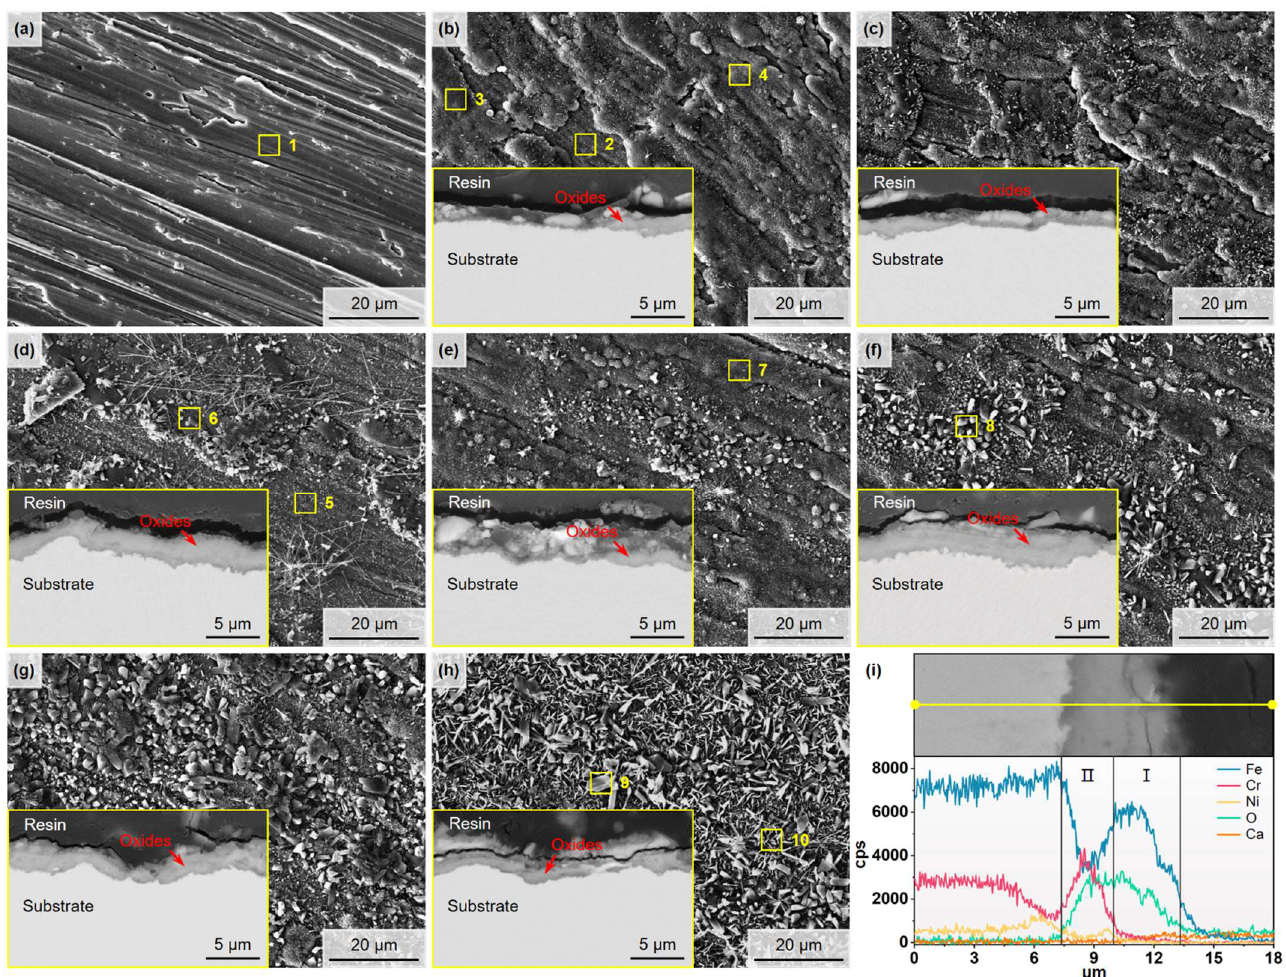
Figure 7. Surface and cross-sectional micrographs of 304SS alloy exposed to Solar Salt at 565 °C for ( a ) 0 day, ( b ) 1 day, ( c ) 3 days, ( d ) 5 days, ( e ) 7 days, ( f ) 9 days, ( g ) 12 days, and ( h ) 15 days. Panel ( i )